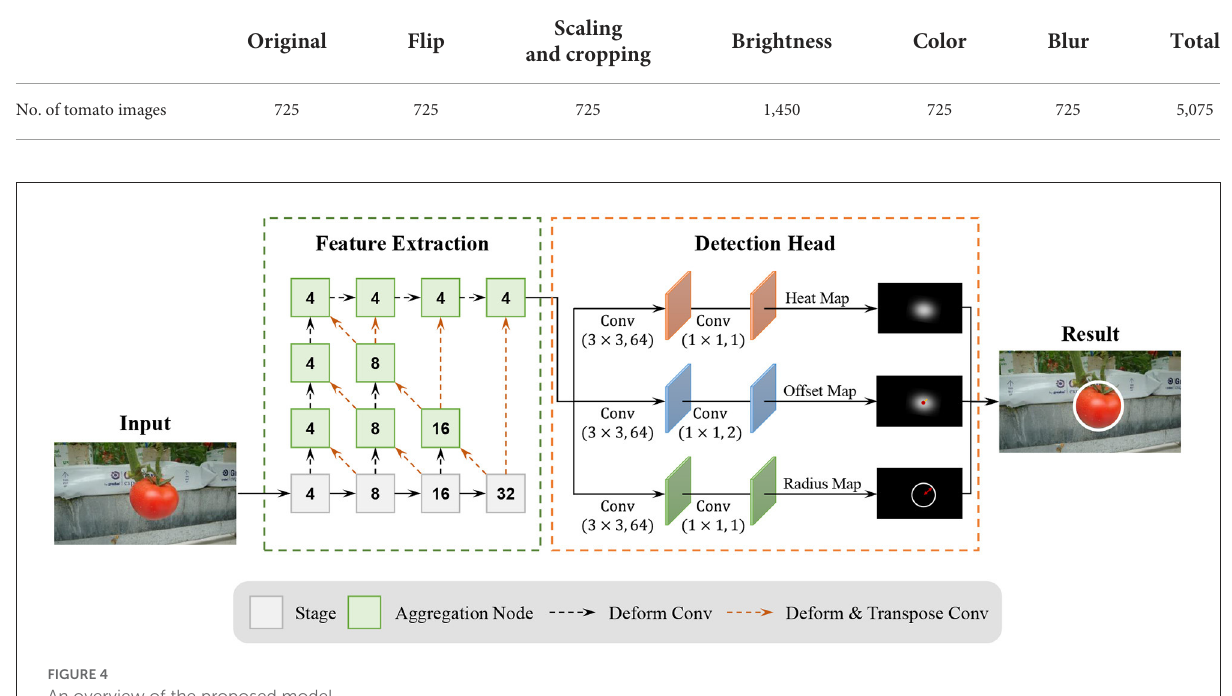
FIGURE4 An overview of the proposed